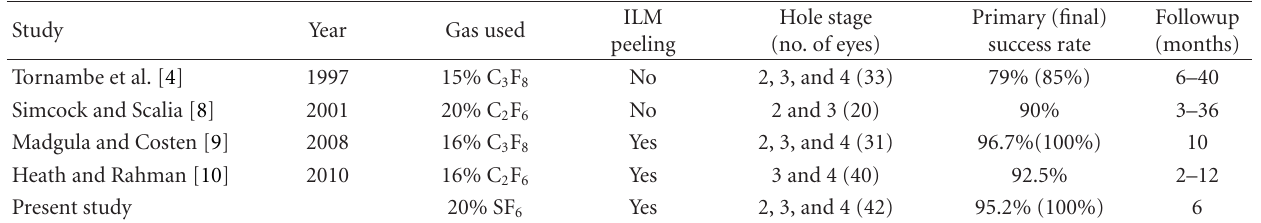
Table 2: Methods and results of studies of combined vitrectomy with phacoemulsification without postoperative face-down positioning.